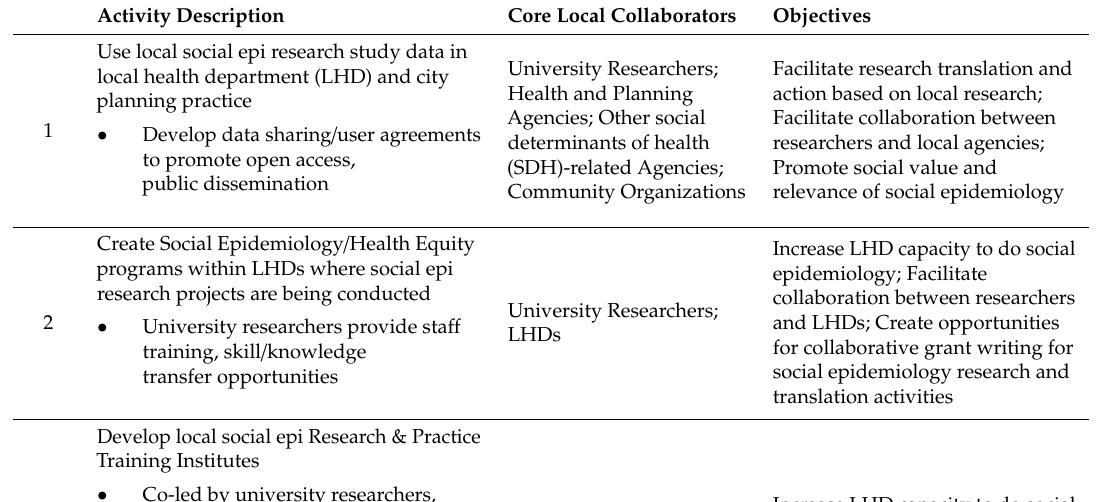
Table 2. 10 ways to move towards a people’s social epi through local